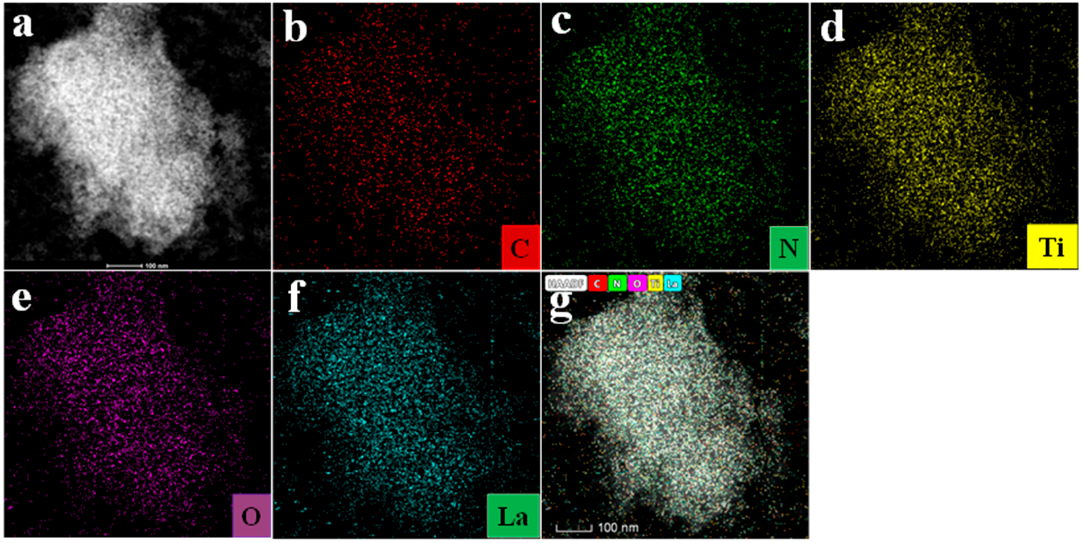
Figure 3. ( a – g ) TEM mapping images of CN/La-N-TiO 2 photocatalyst at high magnifications. The composition and element valence of g-C 3 N 4 , La-N-TiO 2 , and CN/La-N-TiO